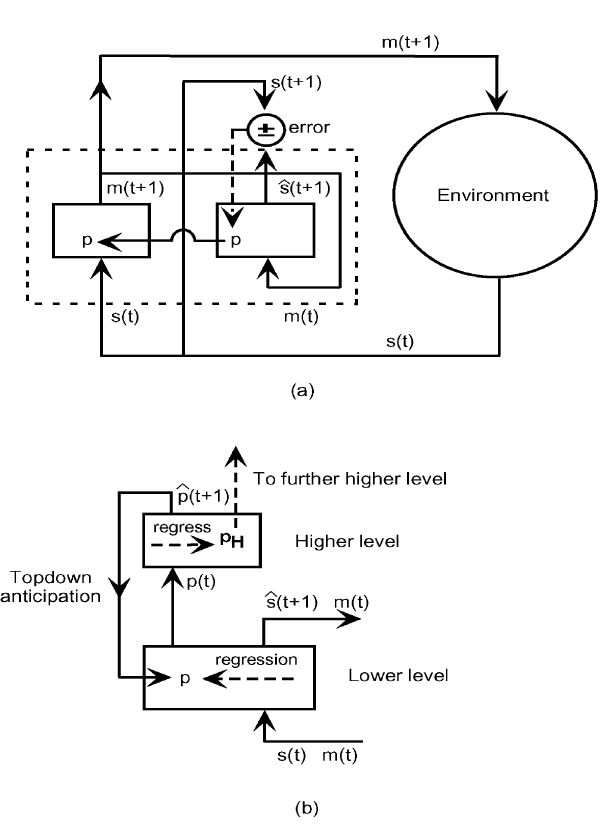
Figure 2. ( a ) Behavior system with anticipation and regression mechanism . ( b ) Extension to multiple levels. m ( t ) and s ( t ) represent the currentmotorandsensorypatterns.prepresentstheinternalparameterwhich corresponds to the PB vector in the later